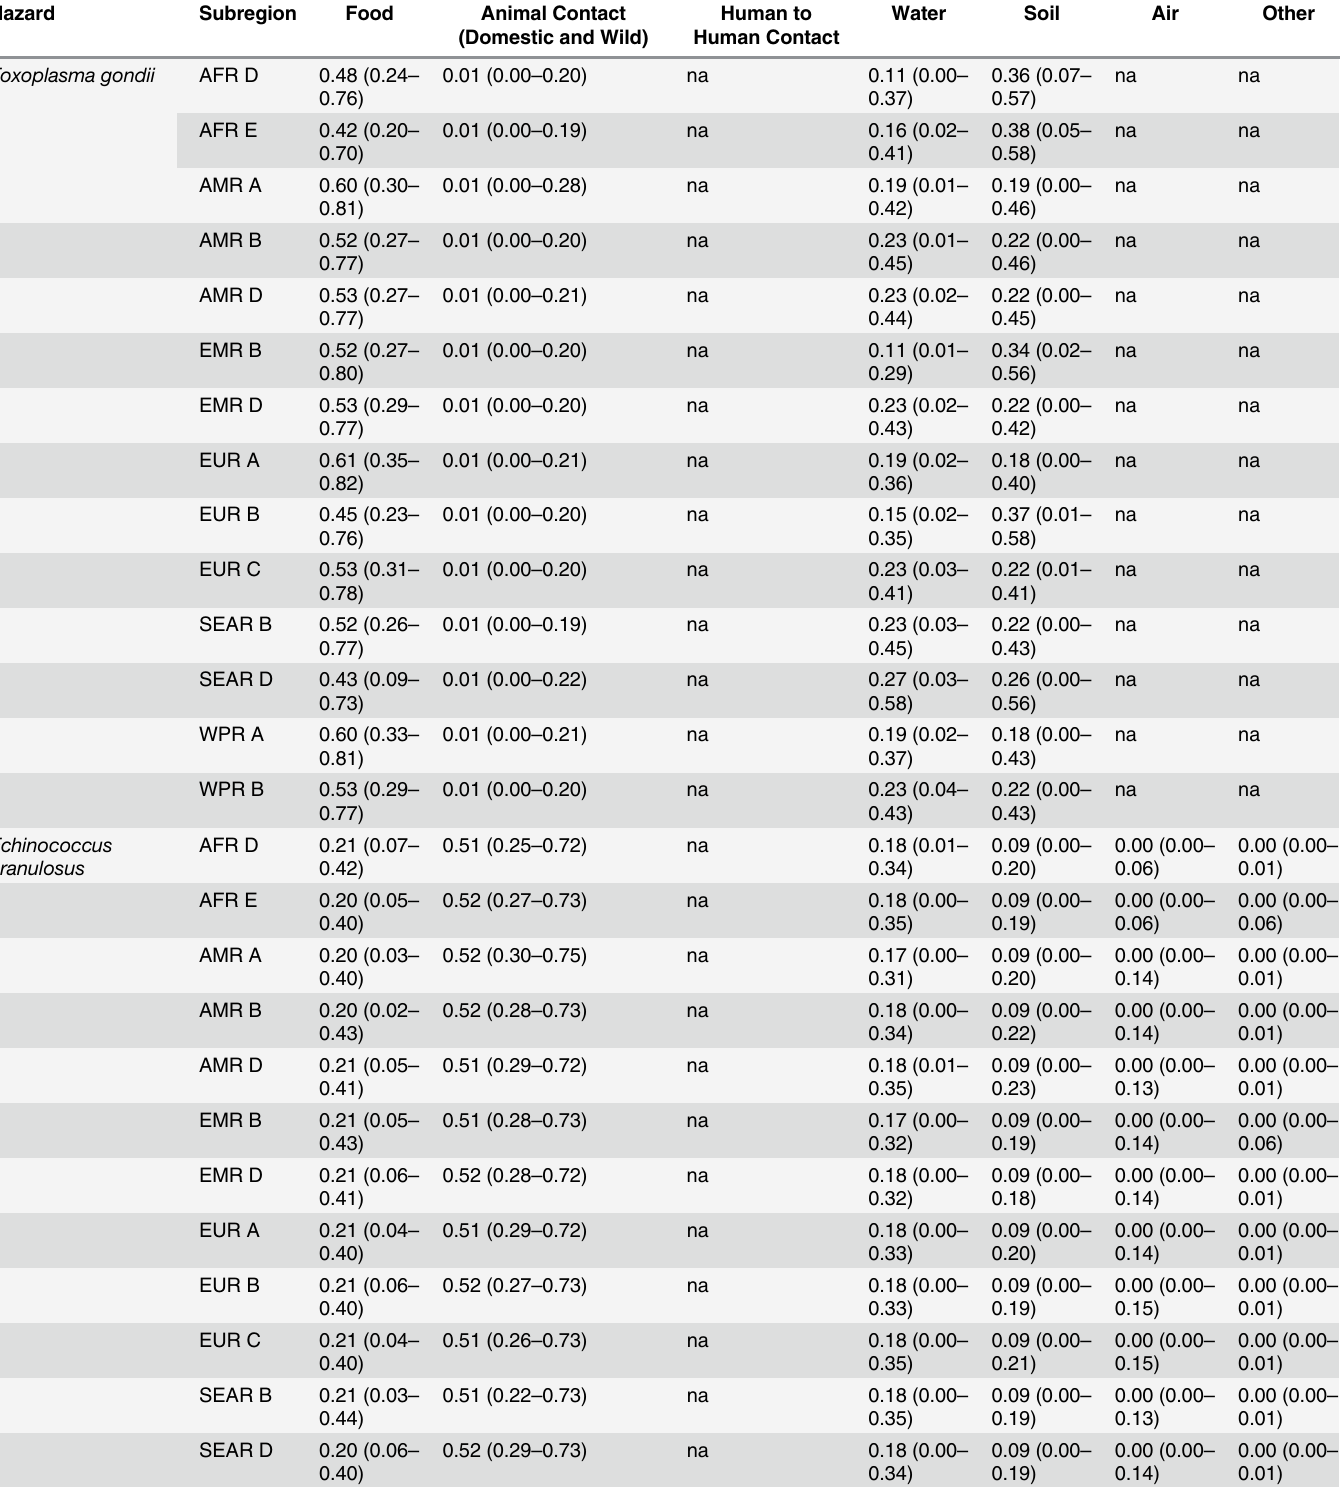
Table 8. Subregional estimates (median and 95% uncertainty interval) of the proportion of illnesses caused by Toxoplasma gondii , Echinococcus multilocularis , Echinococcus granulosus and Ascaris spp. through each exposure pathway. Hazard Subregion Food Animal Contact Human to Water Soil Air Other (Domestic and Wild) Human Contact Toxoplasma